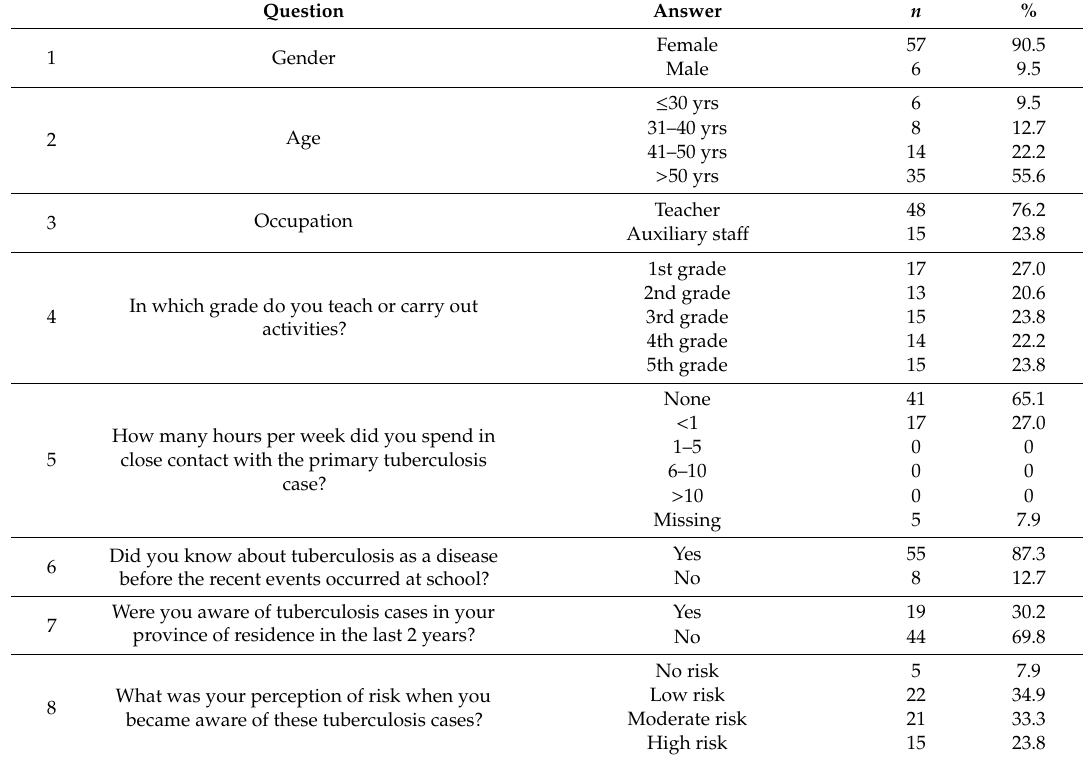
Table 2. Responses given by school sta ff , risk perception questionnaire n =